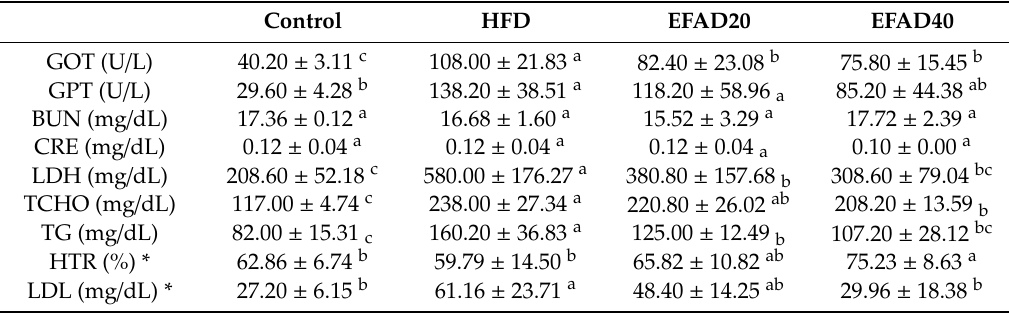
Table 1. E ff ect of ethyl acetate fraction from from Aruncus dioicus var. kamtschaticus (EFAD) on blood serum characteristics of High fat diet (HFD)-induced obese mice.